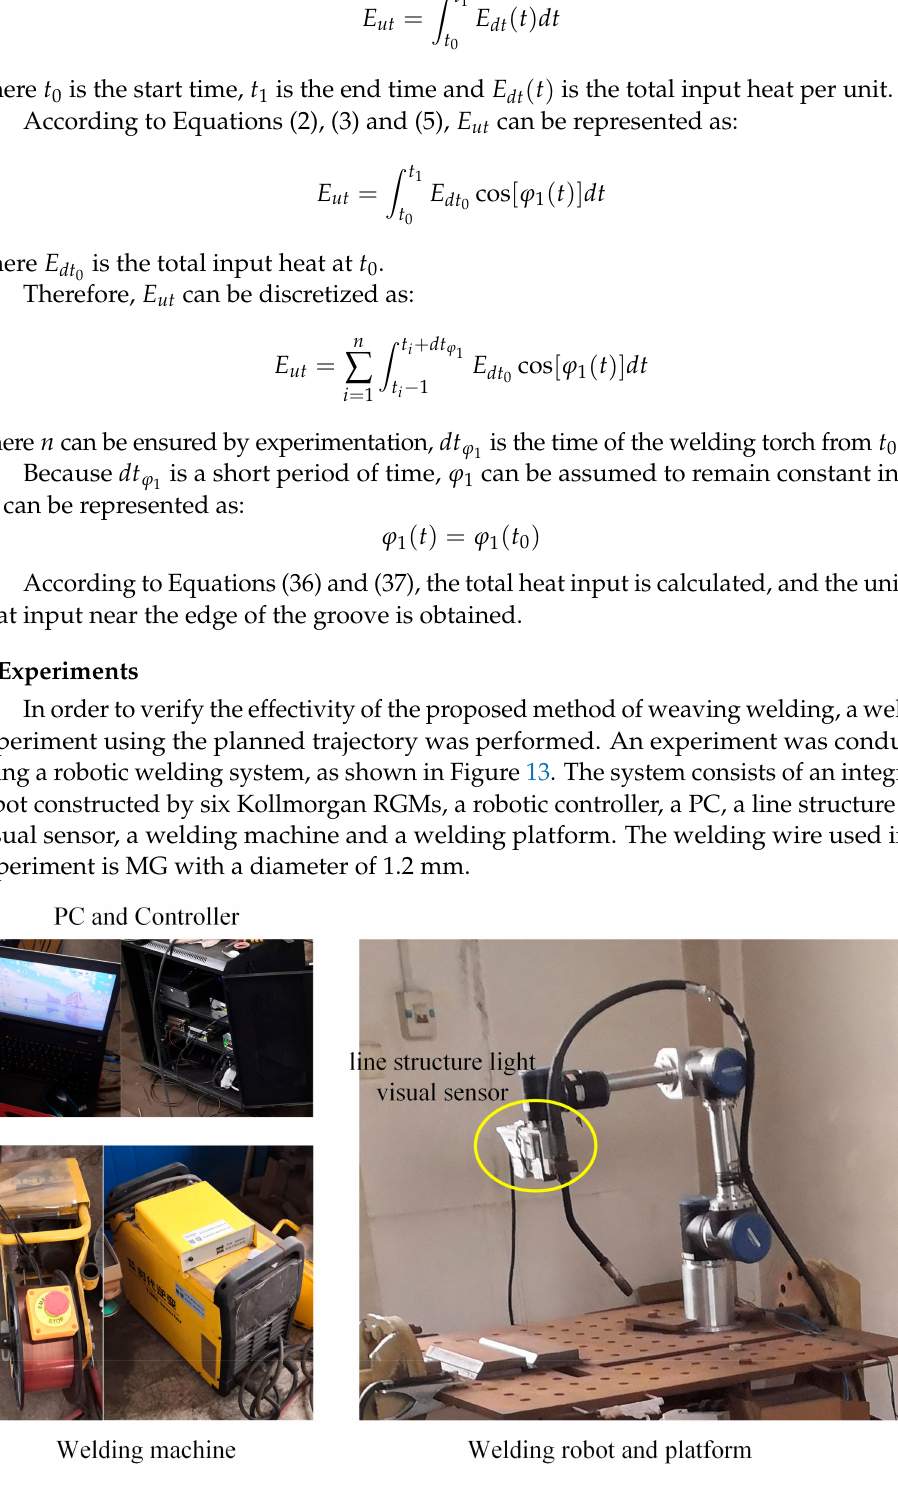
Figure 13. The robotic arc welding